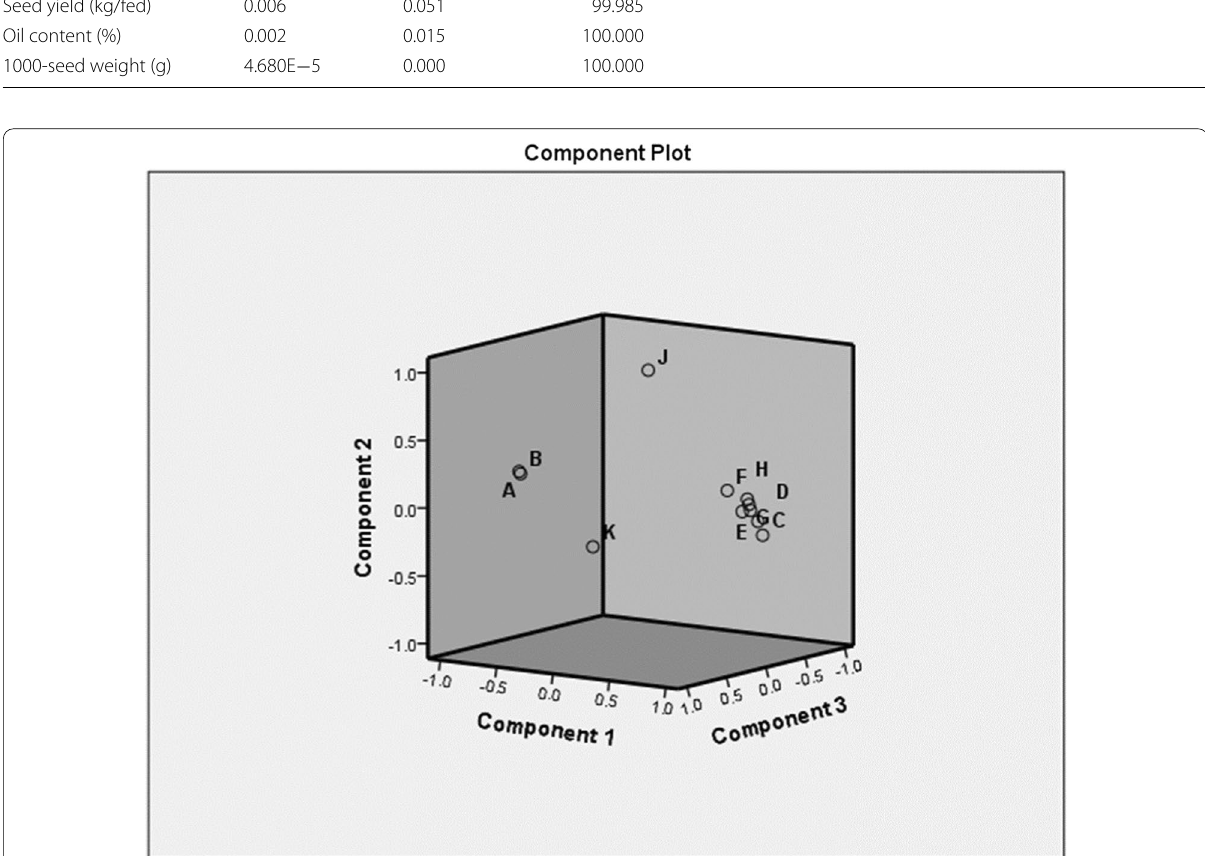
Fig. 4 Loadings plot of PC1, PC2 and PC3 for the component number of disease parameters, plant growth parameters and yield components in response to sunflower powdery mildew disease in the pooled data of 2019 and 2020 seasons. Details—A: FDS (%), B: AUDPC, C: efficacy %,